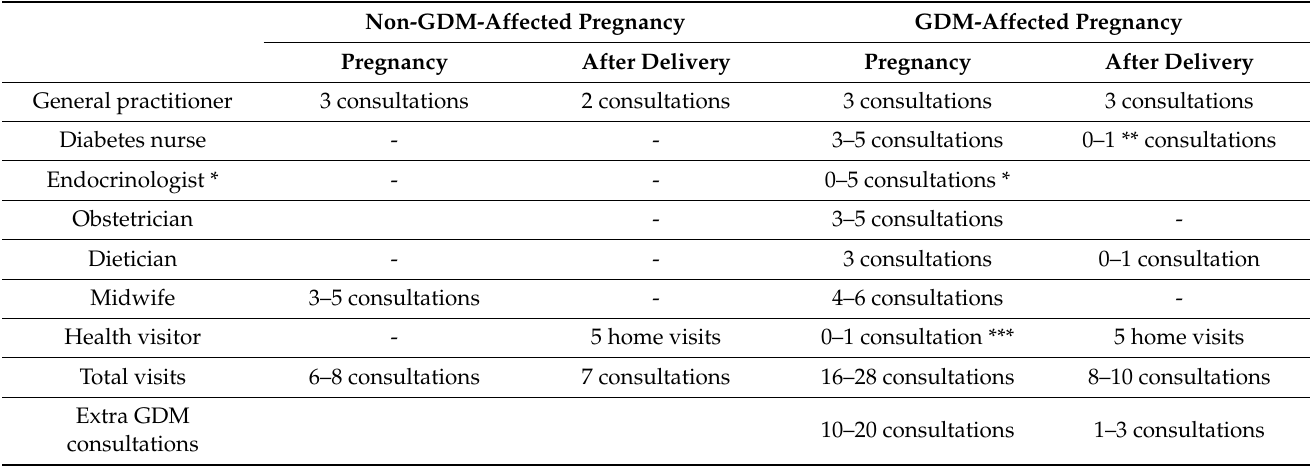
Table 1. Trajectory of Danish gestational diabetes mellitus (GDM) care during and after pregnancy compared to standard care for non-GDM-affected pregnant women. Non-GDM-Affected Pregnancy GDM-Affected